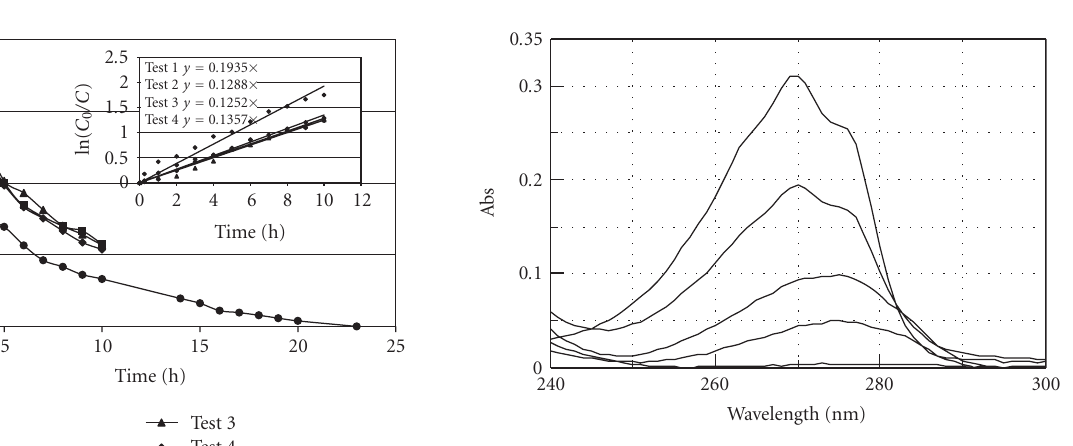
Figure 3: The example spectra of the reaction solution recorded during the photocatalytic process. From top: starting solution, after 1 hour of the process, after 5 hours of the process, after 10 hours of the process, and after 23 hours of the process.